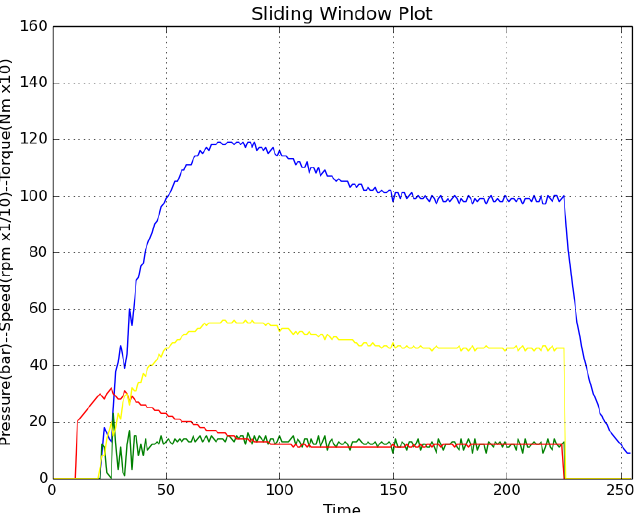
Figure 16. Pressure loop at 100